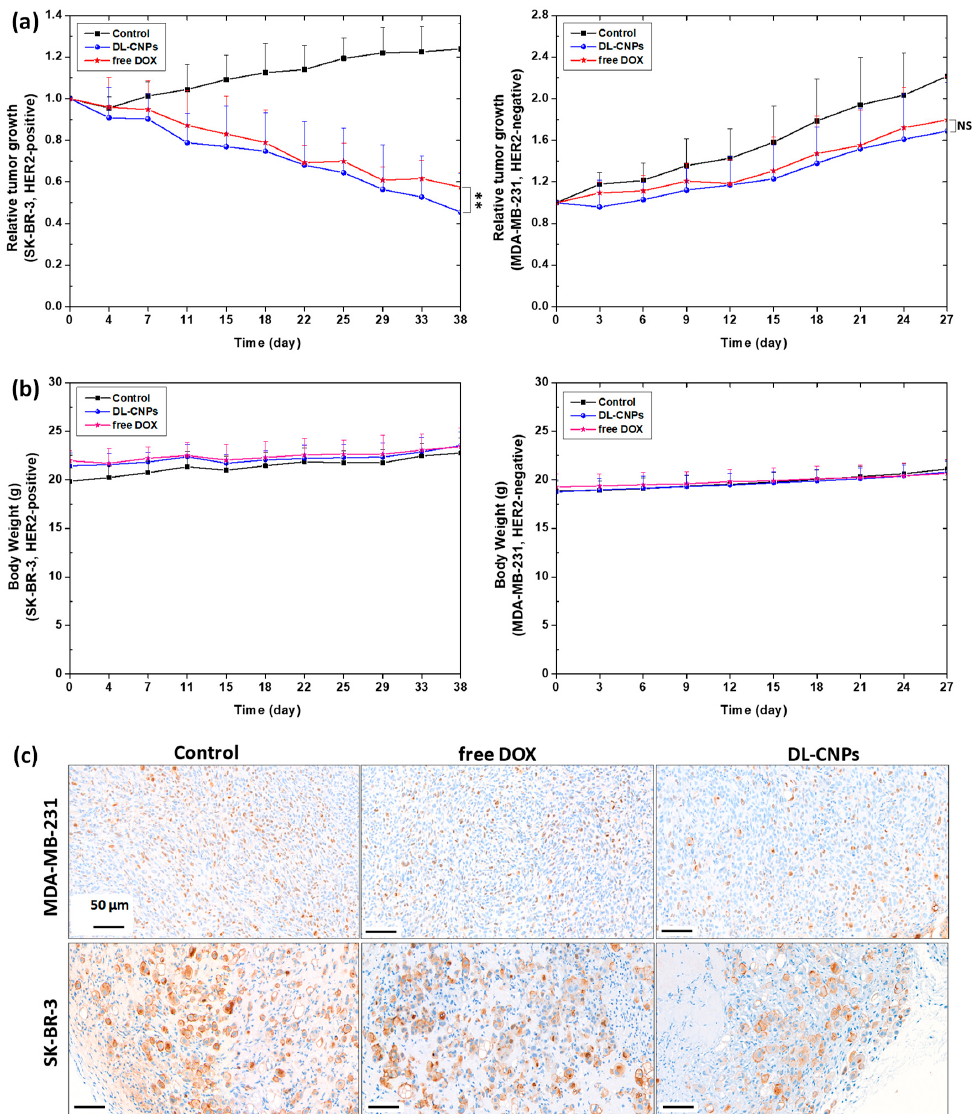
Figure 5. In vivo evaluation of DL-CNPs against HER2-positive and negative xenograft models based on ( a ) tumor growth, ( b ) body weight, and ( c ) histological analysis of Ki-67 expression in representative tumor tissue sections. For drug treatment groups, 1 mg/kg of DOX was injected weekly within 200 µ L saline (n ≥ 7 per group).